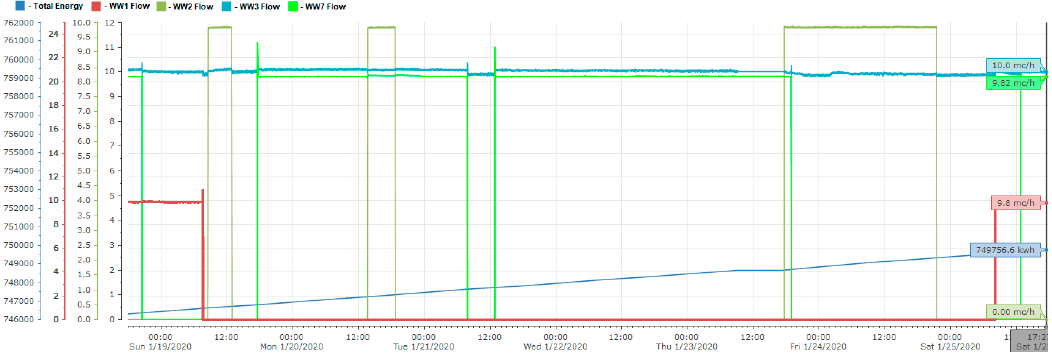
Figure 13. Results without FDC. Well flows (mc/h) and energy consumption (kWh) in Week 1 of tests.